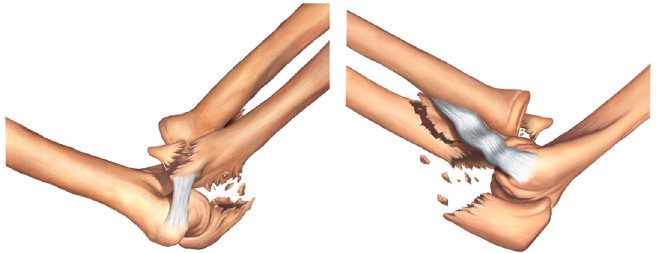
Figure 6. Type IIIA fracture—transolecranon fracture of the proximal ulna with associated fracture of the supinator crest.